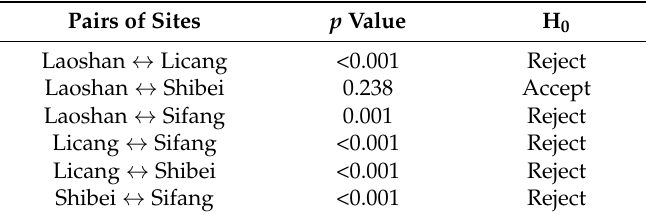
Table 3. Results of AQI difference test among the four sites.